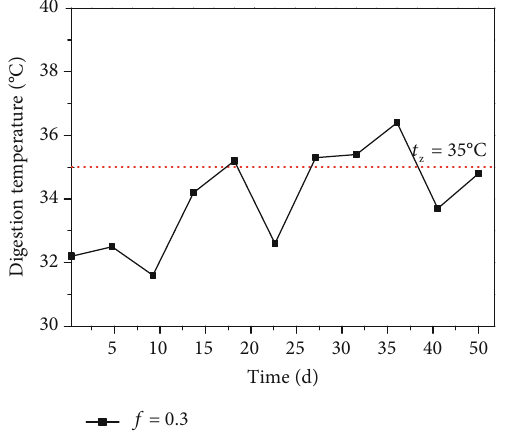
Figure 13: Daily average digestion temperature in the